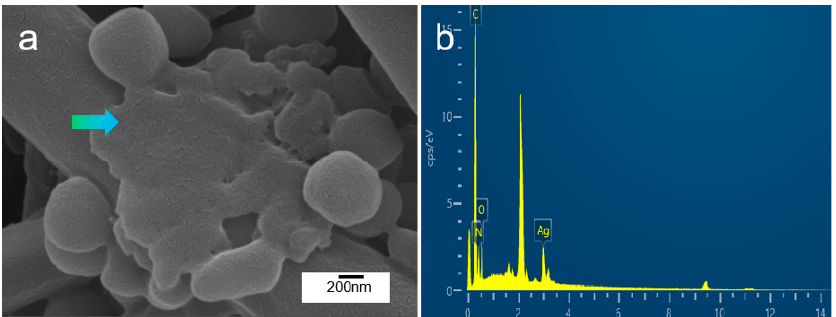
Figure 10. Morphology ( a ) and point scan EDS spectrum ( b ) of S. aureus . cultivated on the SF/GEL/KA-N/AgNWs film.